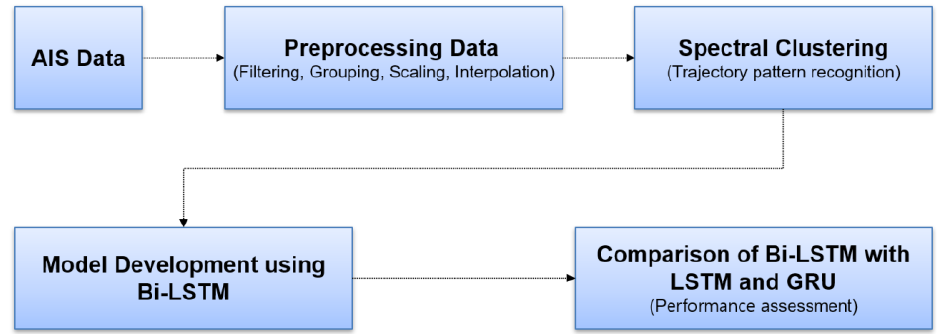
Figure 1. The proposed method for ship trajectory prediction.